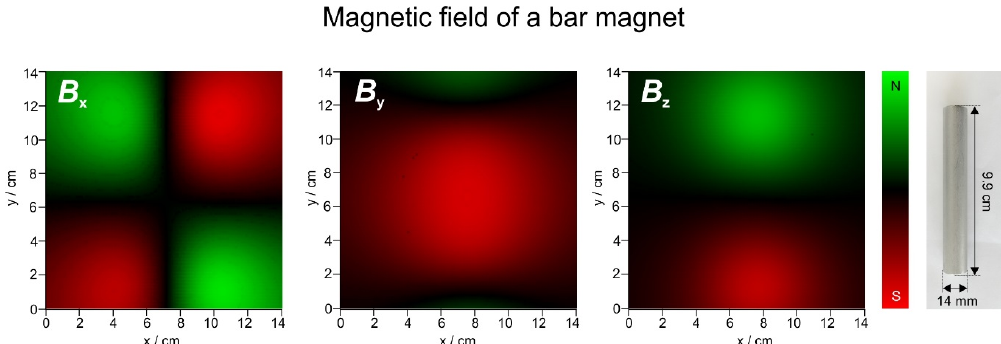
Figure 7. Magnetic field of a bar magnet (image on the right shown to scale) in x , y and z direction. The scale goes from − 28 to 28 G for x , − 53 to +53 for y and − 71 to +71G for z , respectively. Because for the present analysis the sign (N or S) is not important, the field can also be displayed in terms of absolute intensity, and the three components can then be translated to the three primary colours, red ( x ), green ( y ) and blue ( z ). These images are then combined to a composite RGB image. This procedure is shown in Figure 8.